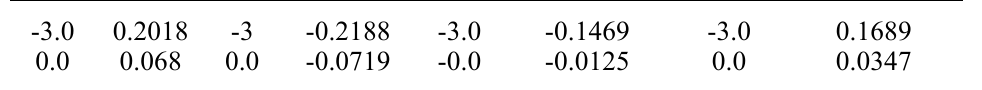
with ionic concentration. 2